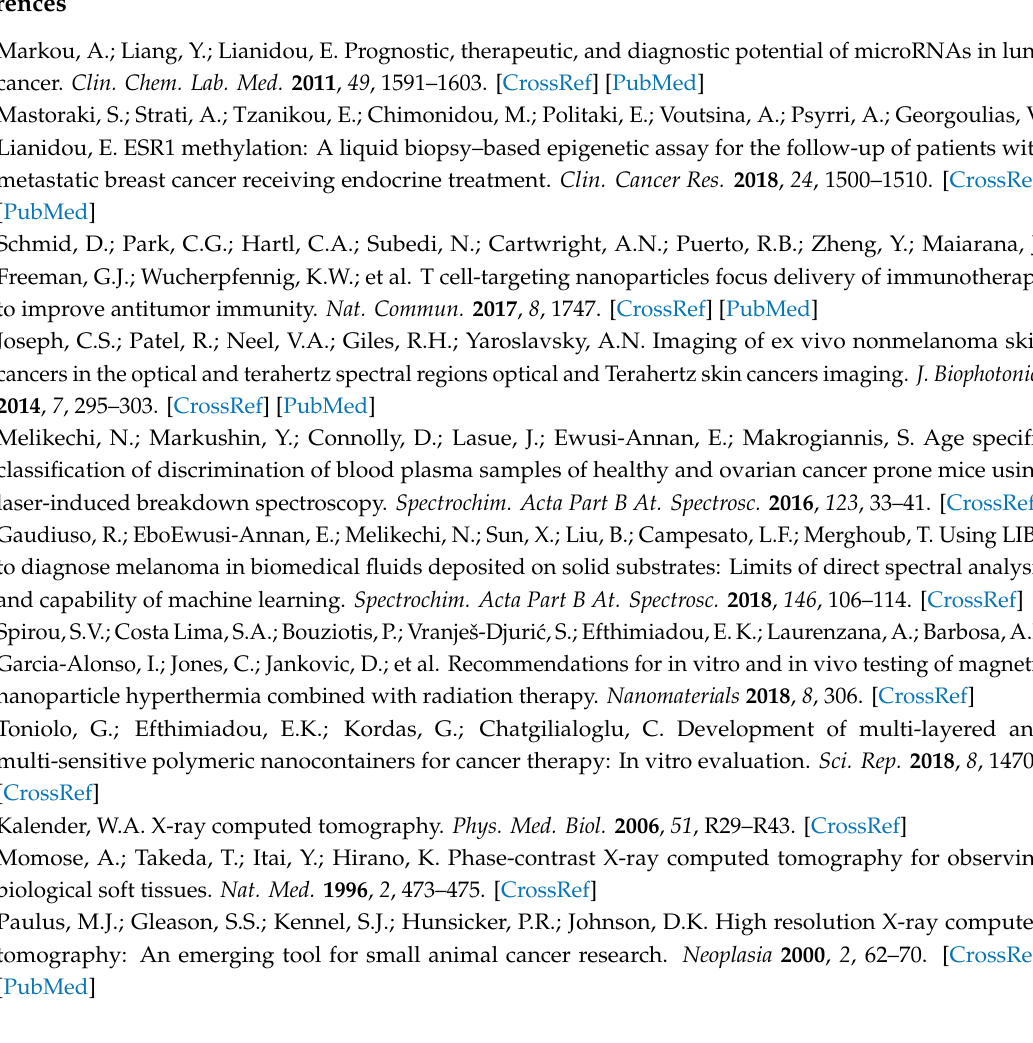
Figure S1: FTIR spectra of OA and OA-stabilized Lu-NPhs, Figure S2: acrylic sample holder photo and definition of region of interest (ROI) in CT, Figure S3: micro-CT images of iodinated molecules, Figure S4: typical TGA spectrum of OA-stabilized NPhs, Figures S5–S10: FTIR spectra of PAA-stabilized Gd-, Yb-, Ta-, Eu-, Er-, and Lu-NPhs, Figures S11–S16: TGA spectra of PAA-stabilized Gd-, Yb-, Ta-, Eu-, Er-, and Lu-NPhs, Figures S17–S18: TEM images of OA- and PAA-stabilized Eu-, Lu- and Ta-NhPs, Figures S19–S20: TGA spectrum, FTIR, and micro-CT image of low grafted PAA’-stabilized Lu-NPhs, Tables S1–S2: Attenuation coe ffi cient values of all the synthesized OA- and PAA-stabilized NPhs as well as those of the carrier